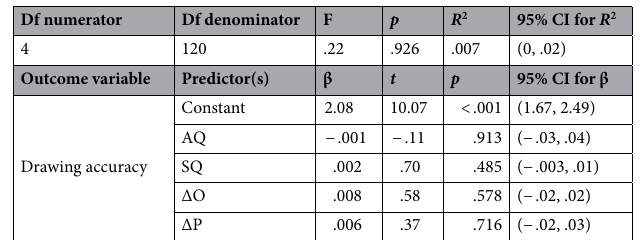
Table 2. Regression analysis using the four local processing measures (AQ, SQ, ΔO, ΔP) as predictors of variation in drawing accuracy. None of the predictors significantly explain variation in realistic drawing ability, supporting the argument that the presence of a local processing bias is not indicative of superior realistic drawing